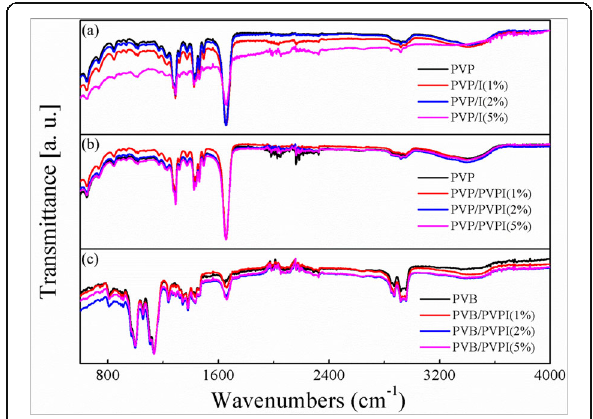
Fig. 4 FTIR spectra of the as-spun fibers PVP/I ( a ), PVP/PVPI ( b ), PVB/PVPI ( c